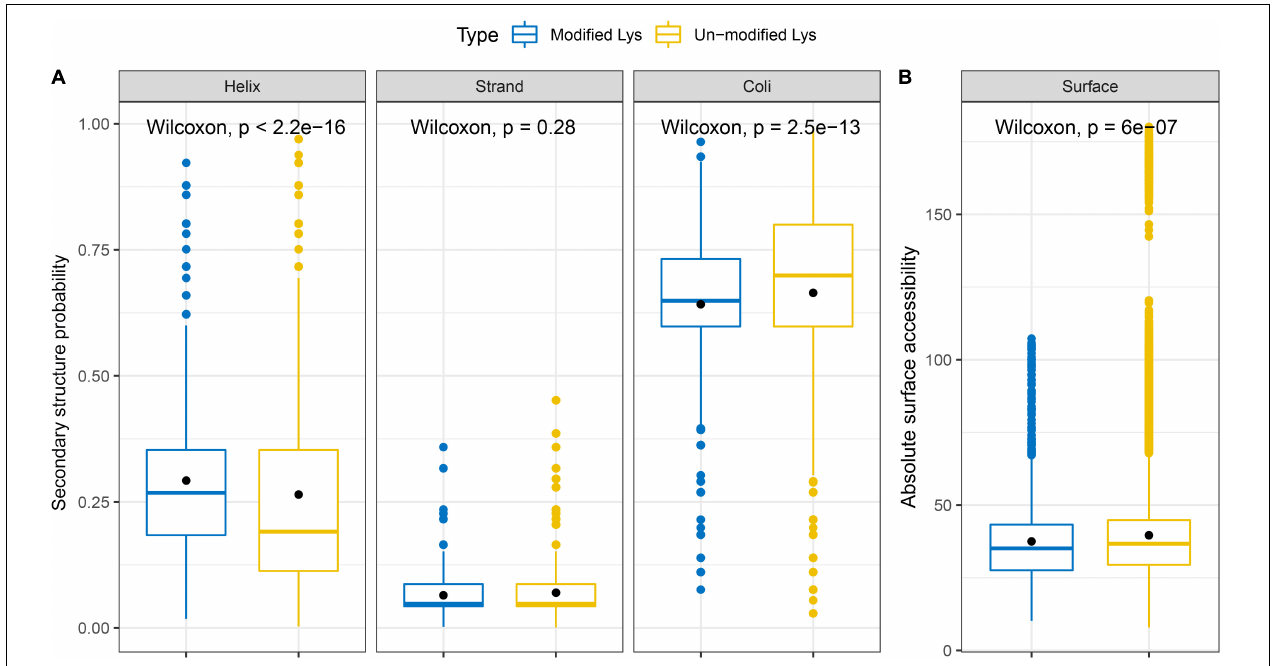
FIGURE 11 | Properties of succinylated sites based on the (A) secondary structure probability and (B) absolute surface